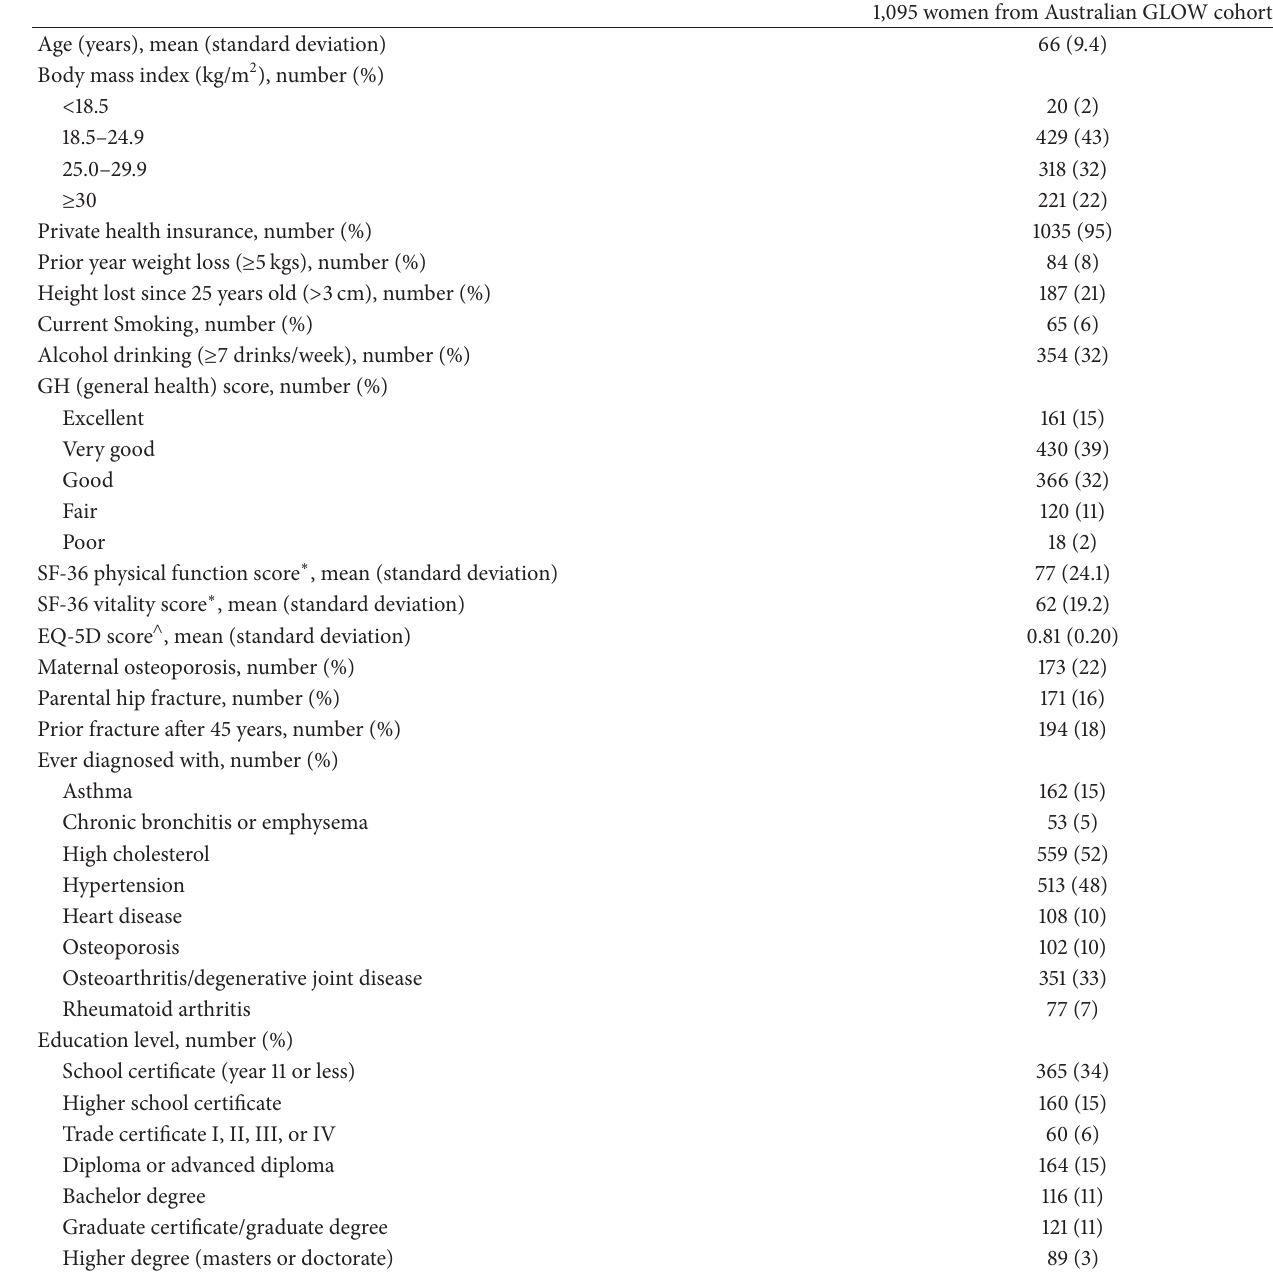
Table 1: Baseline (first assessment) characteristics of the study